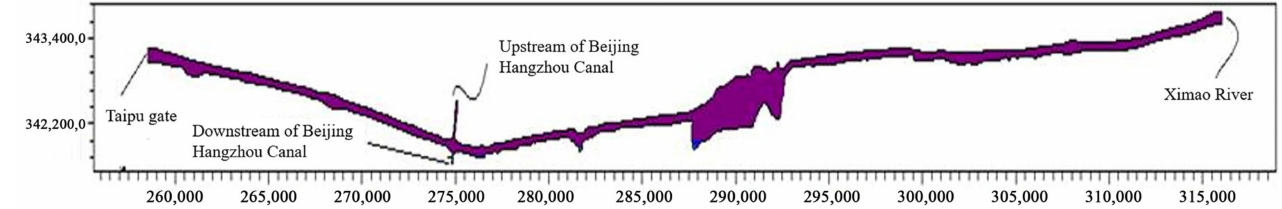
Figure 1. Typical cross-border river in the Yangtze River Delta region. Schematic diagram of the research area of the Taipu River (the dimensions in the picture are in